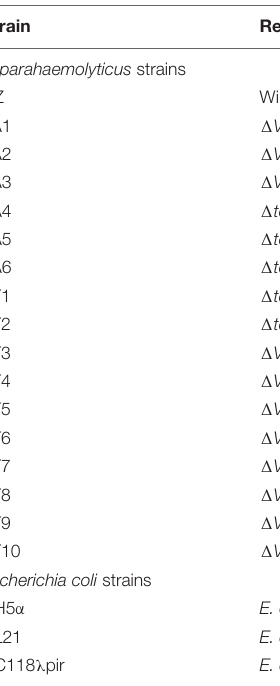
TABLE 1 | Bacterial strains and primers used in this